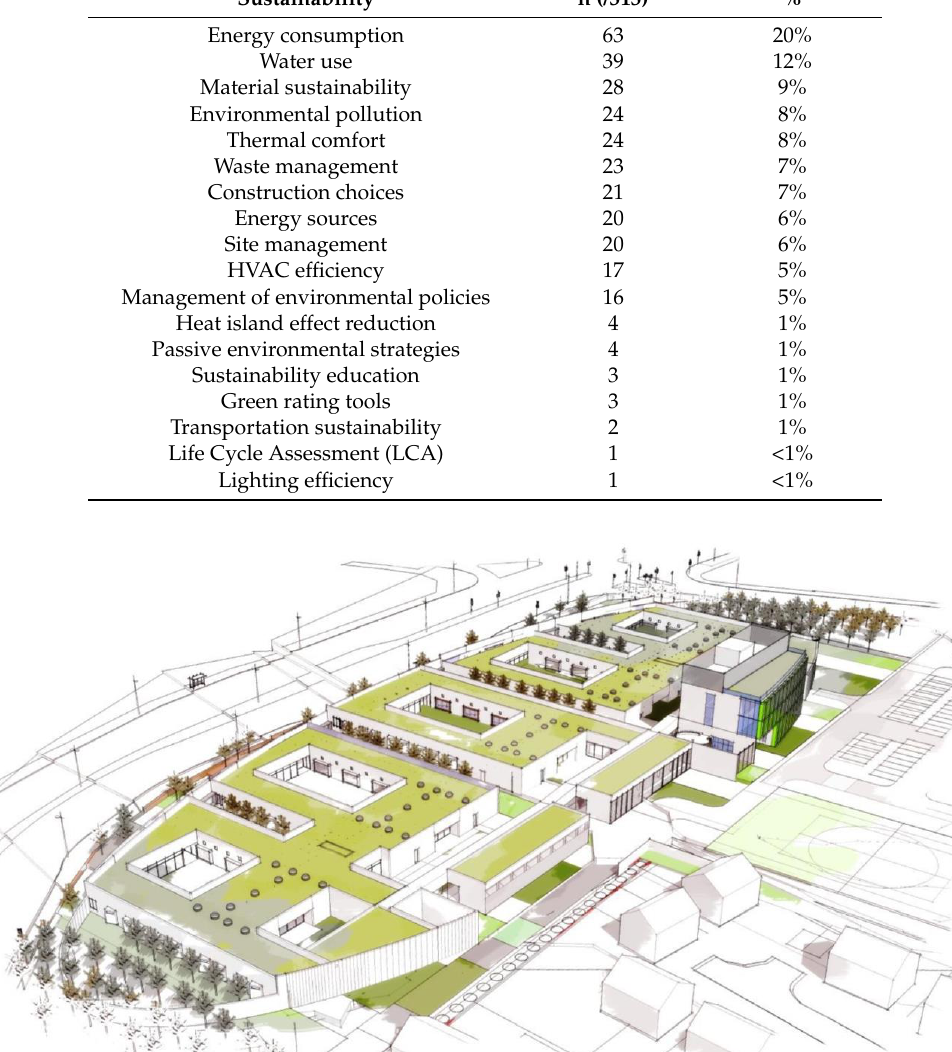
Figure 4. Early visualization of the Edge Lane Hospital, taken from Medical Architecture reports available online [56]. Table 11. Number and percentage of indicators grouped according to Sustainability topics.